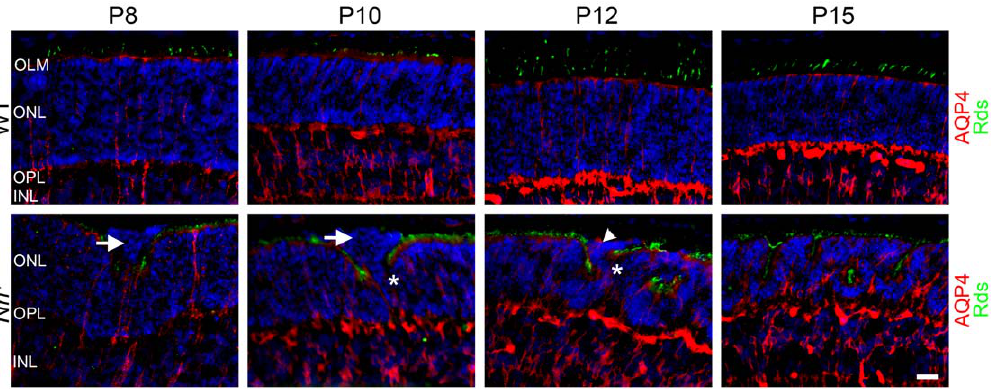
Figure 10. Early aberrant photoreceptor populations lack significant staining for Mu ¨ ller cell markers. In order to visualize the position of the Mu¨ller cells within the retina, sections were stained with antibodies specific for AQP4 (red) to label Mu¨ller cell bodies and S-opsin (green) to label photoreceptor OSs. Mu¨ller cell staining can be seen to end at a distinct line which corresponds to the OLM. Gaps in this line can be seen at the base of the aberrant photoreceptor populations (astrisks). Early aberrant photoreceptor populations at P8 and P10 lack prominent AQP4 staining, indicating a lack of Mu¨ller cell processes within these cell populations. AQP4 staining is observed within the aberrant photoreceptor populations at P12 (arrowhead). AQP4 staining pattern is indistinguishable from the adult at P15. ONL: outer nuclear layer, INL: inner nuclear layer, OPL: outer plexiform layer. Scale bar, 20 m m.